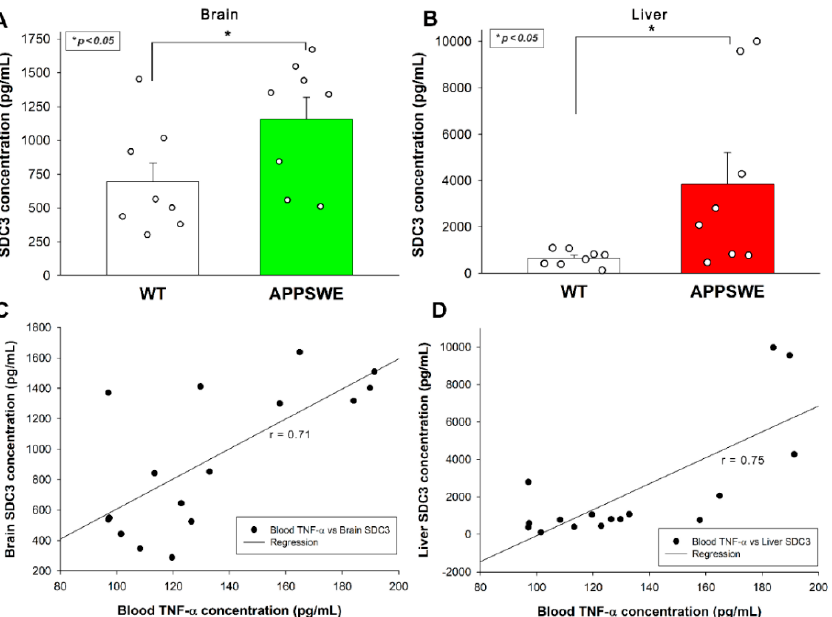
Figure 4. APPSWE-Tau mice exhibits increased SDC3 concentrations in the brain and the liver. ( A , B ) SDC3 concentrations of the brain ( A ) and liver ( C ) extracts of APPSWE-Tau mice and representative WT controls were measured with ELISA. Each group contained 8 animals. The bars represent the mean + SEM. Statistical significance vs. WT was assessed with ANOVA. * p < 0.05. ( C , D ) Linear regression between the TNF- α and SDC3 concentrations in the brain ( C ) and liver ( D